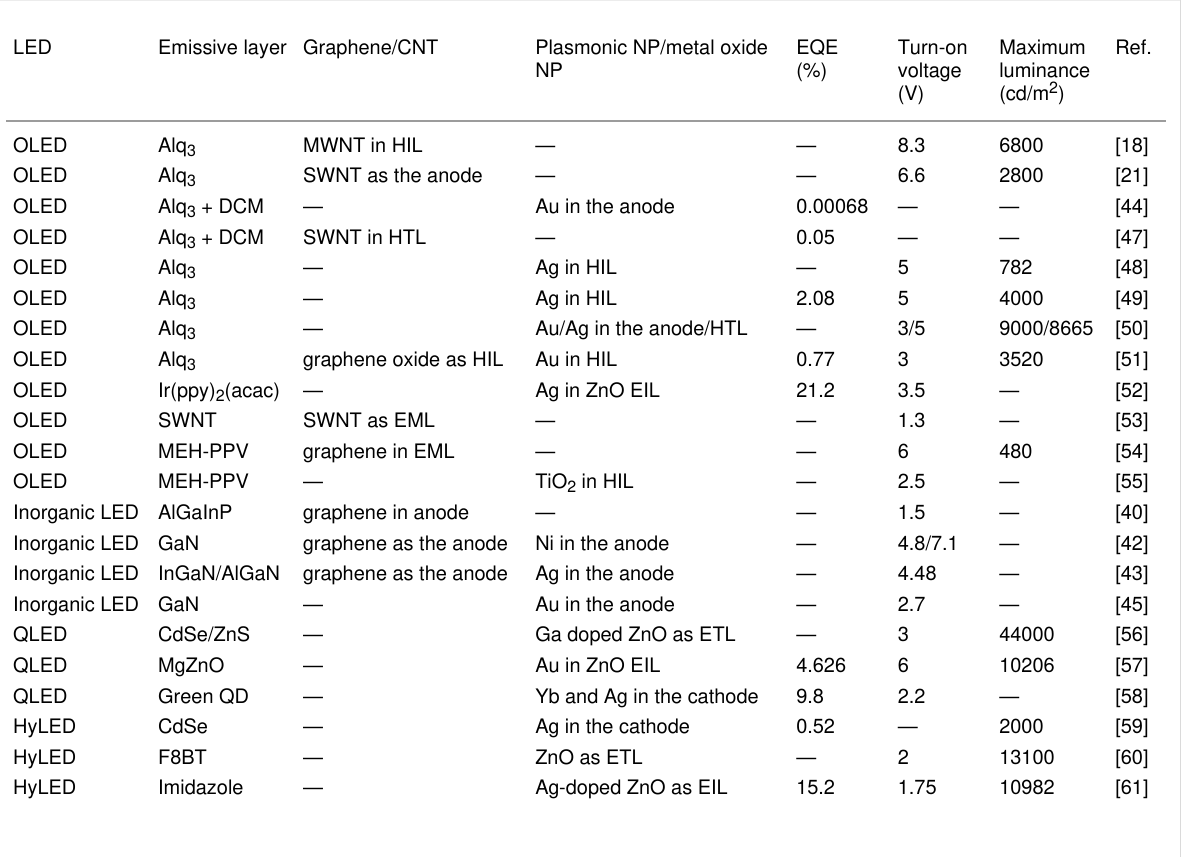
Table 3: EQE, turn-on voltage, and maximum luminance of various LED with carbon nanostructures, plasmonic, and metal oxide NP in the device layers.